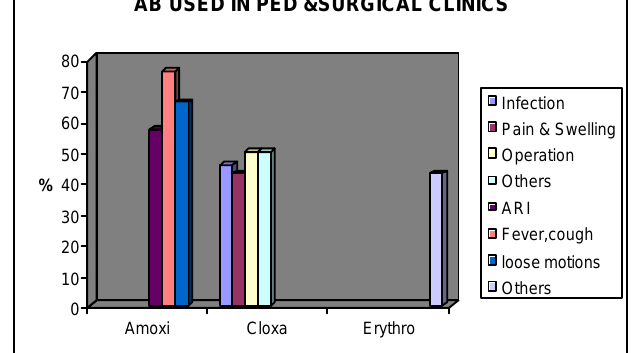
Fig. 5 : Use of Ab in Surgical & Pediatrics Clinics